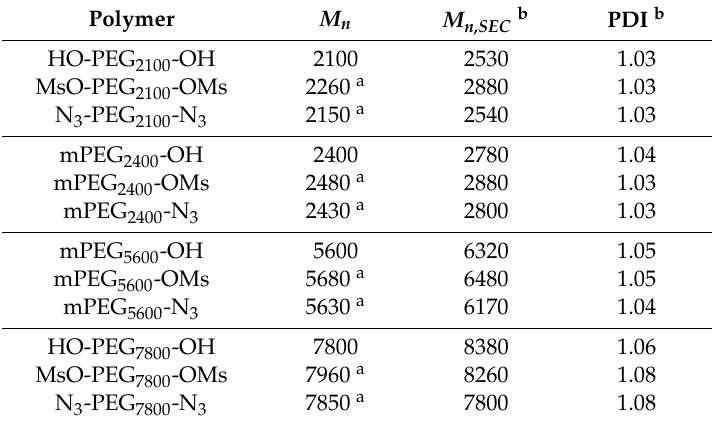
Table 3. Molecular characteristics for some functionalized PEG families as obtained by SEC.